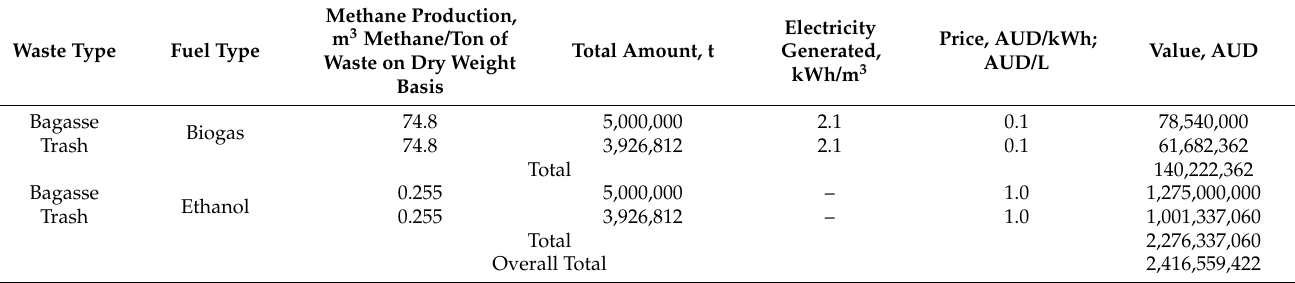
Table 22. Biogas production from sugarcane wastes (bagasse and